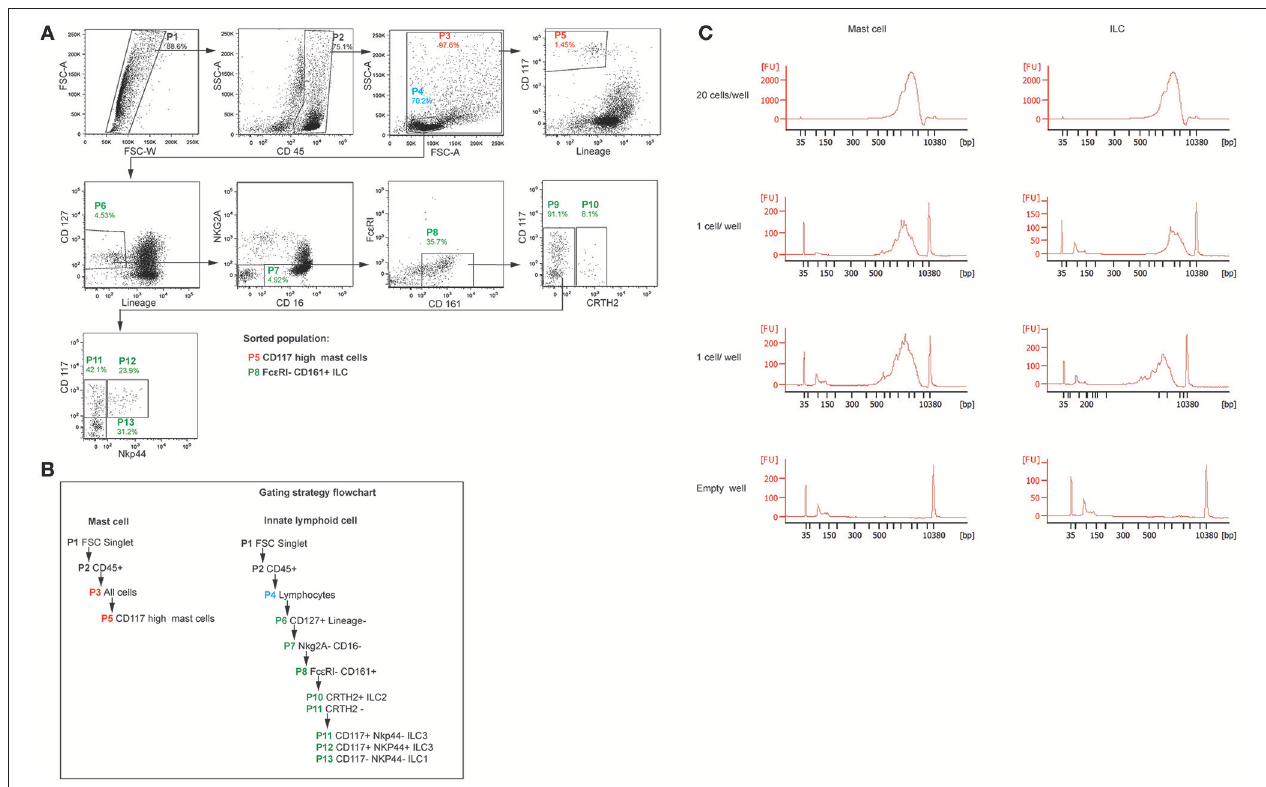
FIGURE 6 | Analysis of single cell RNA quality. (A) Gating strategy for sorting mast cells, ILC. (B) Gating strategy explained as flowchart. (C) RNA quality of single cell sorted mast cells and ILC shown as